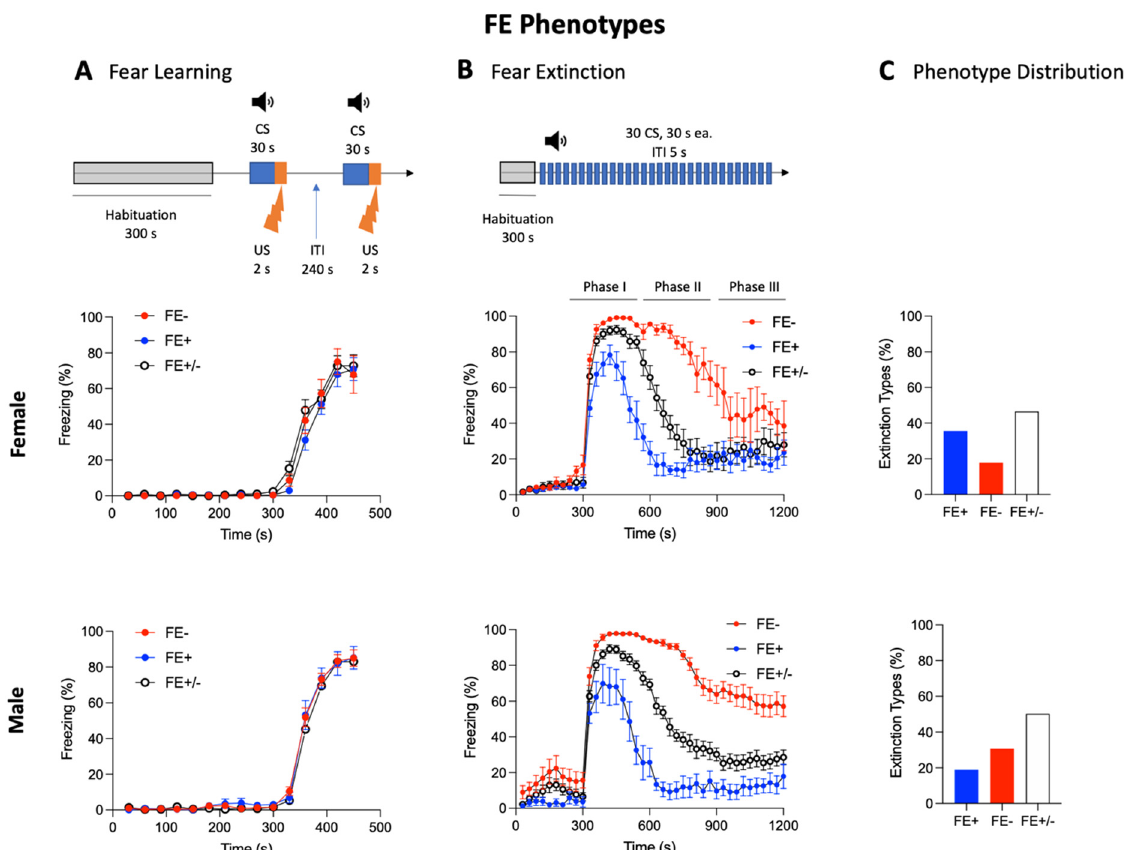
Figure 2. Inter-individual and sex differences in fear extinction learning ability in naïve female and male rats. Fear conditioning on Day 1 ( A ) and extinction ( B ) tests were conducted using two distinct context chambers. ( A ) Fear conditioning on Day 1—rats were habituated to context A followed by fear conditioning (2 CS-US pairs, see Section 2.5.1). The diagram illustrates the experimental protocol. Symbols in the line graph show freezing responses expressed in percent per 30 s segment during fear conditioning with 2 CS-US pairings. ( B ) Fear extinction learning on Day 2—rats were habituated to context B followed by extinction training (30 CSs, no US). The diagram illustrates the experimental protocol. Symbols in the line graph show freezing responses to tone (CS) expressed in percent per 30 s segment. ( C ) Bar histograms show the distribution of rats with strong (FE+), “normal” (FE+/ − ), and weak (FE − ) fear extinction. The population (%) of FE+ was larger in female rats compared to male rats. For details, see the “Methods” and “Results” sections. CS: conditioned stimulus; US: unconditioned stimulus; ITI: intertone interval; FE: fear extinction.